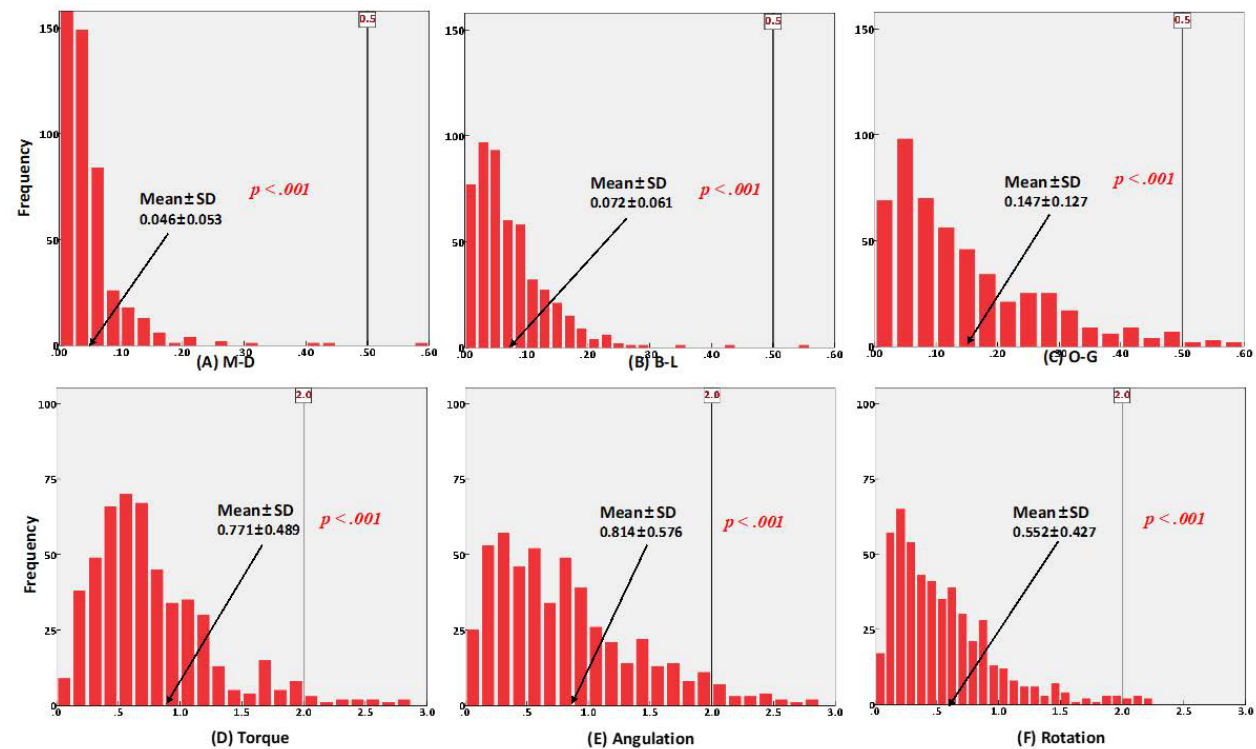
Figure 9. Histogram of frequencies for six measurements with one-tailed equivalence test in group B. ( A – C ) linear measurements, ( D – F ) angular measurements.